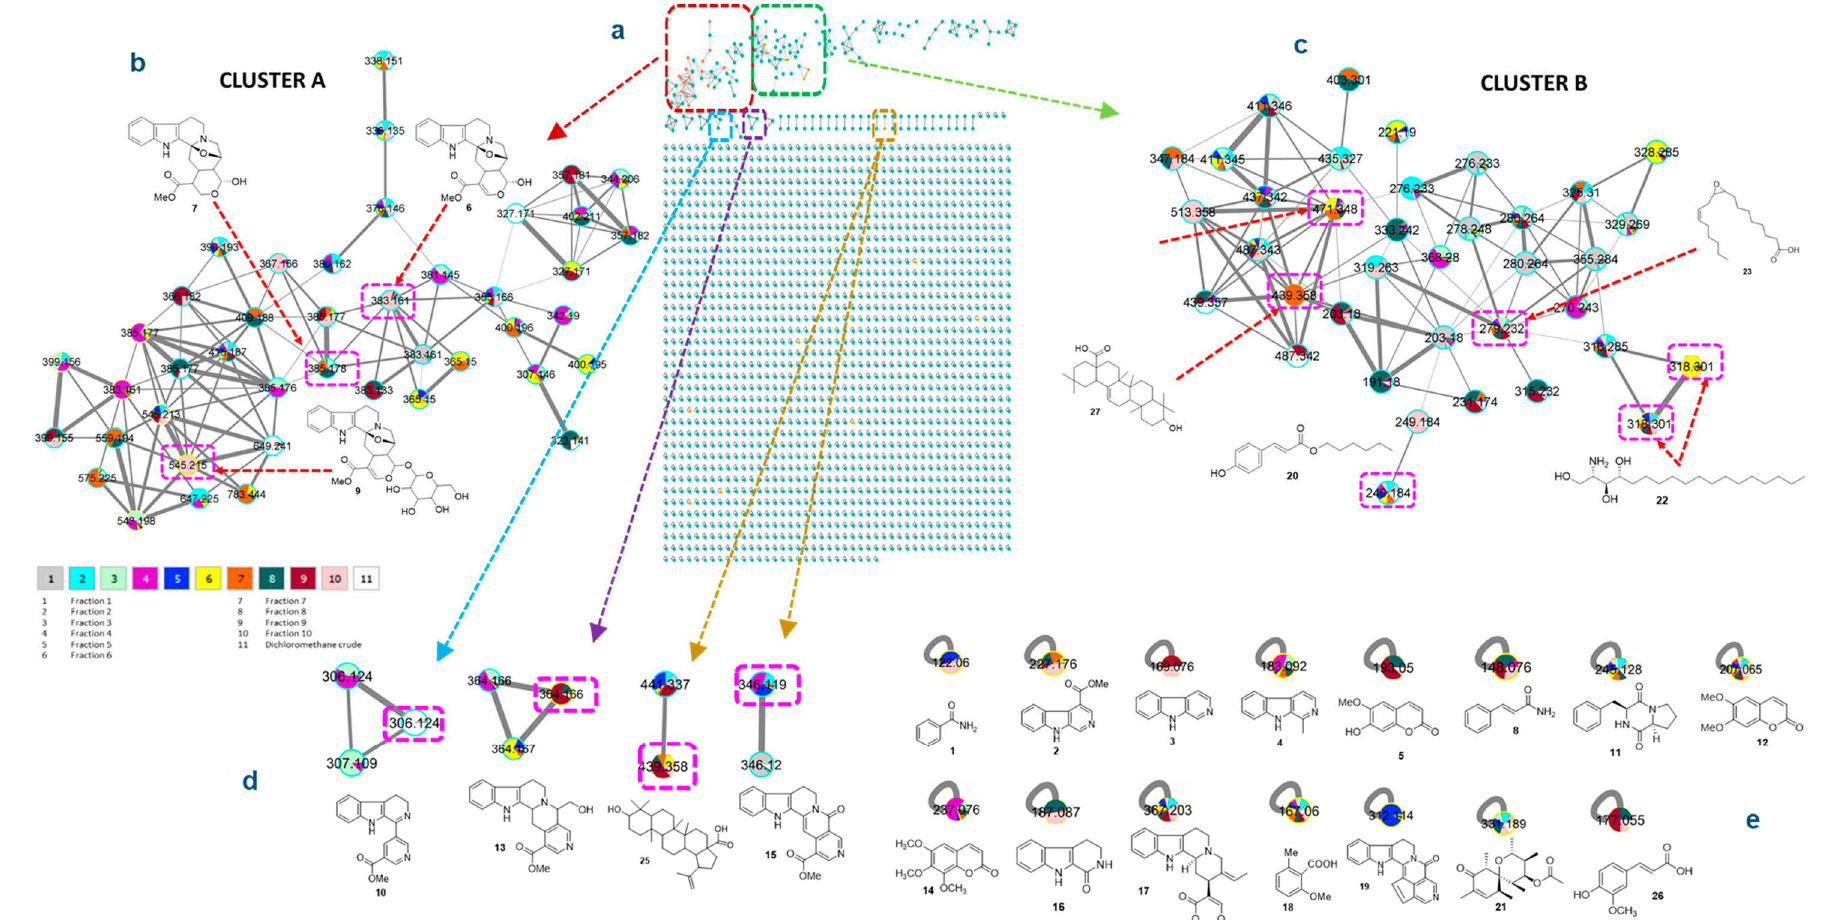
Figure 2. ( a ) Massive molecular networking of dichloromethane crude extract of the bark of O.maingayi ( b ) Implementation of a fraction mapping for molecular networking-guided purification for cluster A. ( c ) Implementation of a fraction mapping for molecular networking-guided purification for cluster B. ( d ) Implemen- tation of a fraction mapping for molecular networking-guided purification for non-prioritized clusters. ( e ) Implementation of a fraction mapping for molecular networking-guided purification for self-loop nodes.